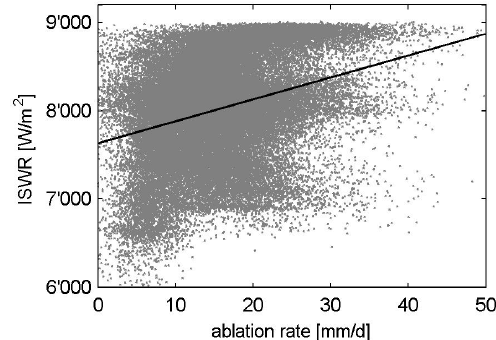
Fig. 11. Scatterplot of SWE ablation rates (26 April–13 May) and mean daily sum of incoming shortwave radiation (ISWR). The solid line draws the linear fit function derived from the univariate regres- sion